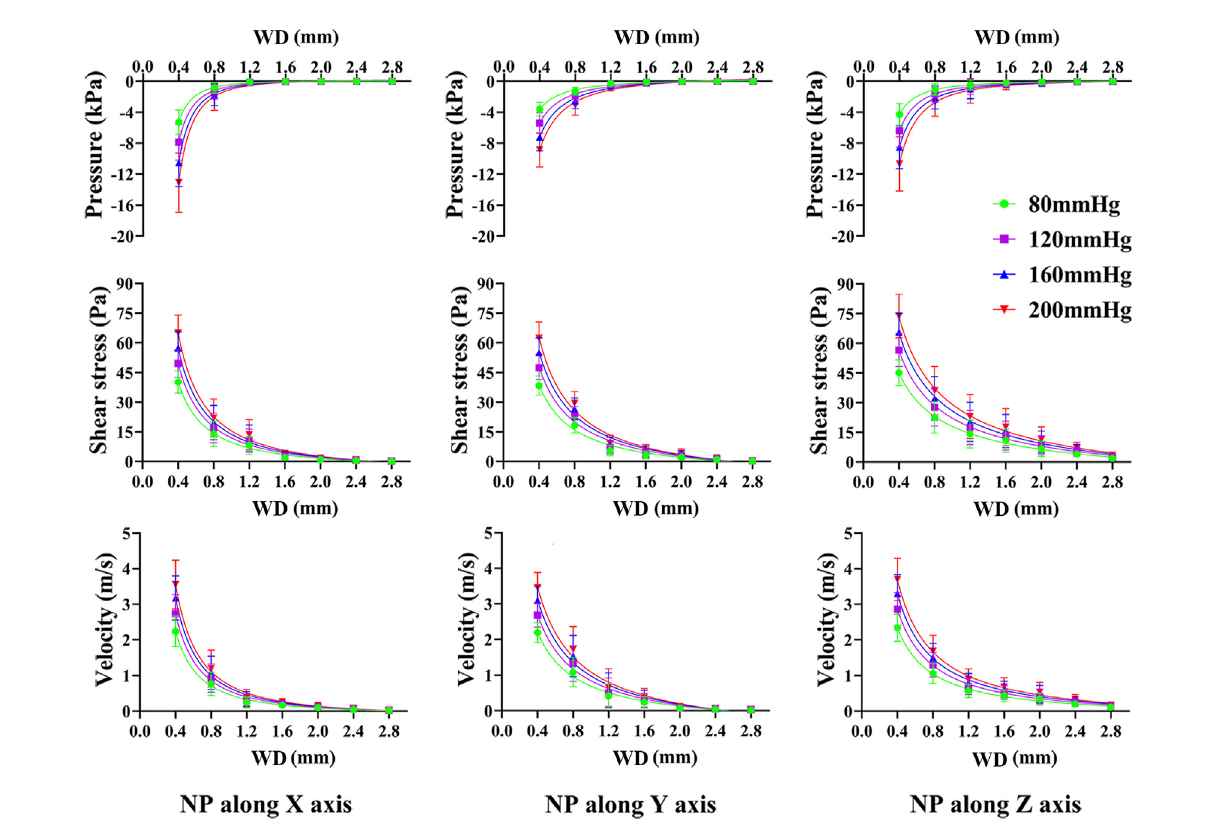
FIGURE 5 Non-linearregressioncurvesbetweendependentvariablesandWDundervariousNPscalesanddirections.Thepressure,shearstressontrabeculae and marrow fl uid velocity decrease exponentially with an increase in WD. NP induce great difference in pressure, shear stress and marrow fl uid velocity only within a short